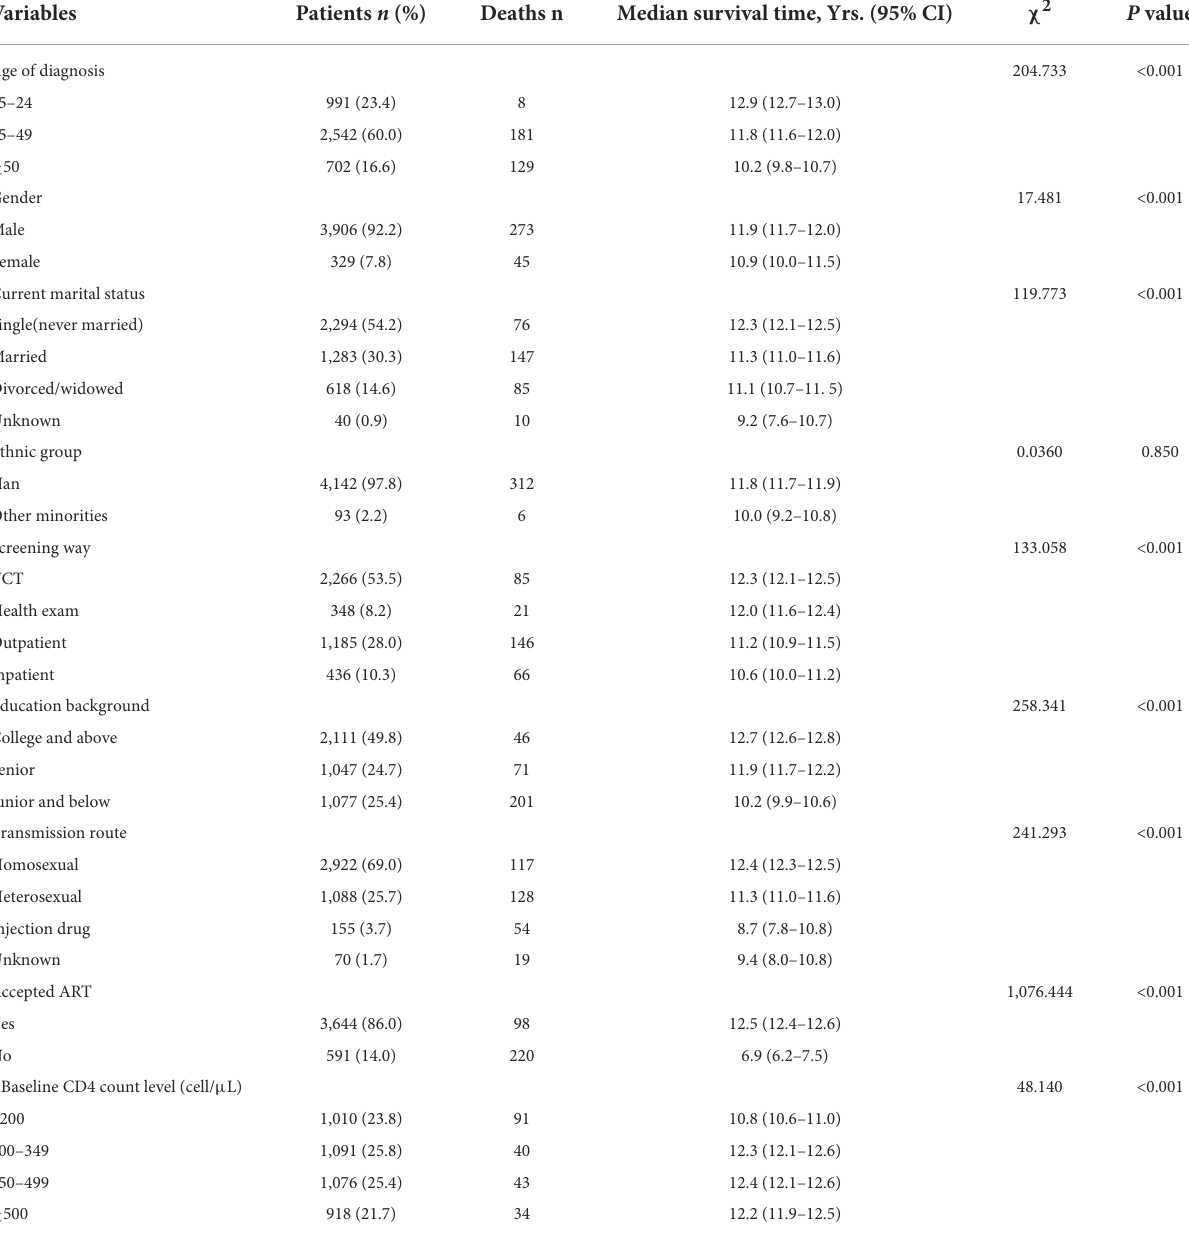
TABLE 2 Survival time and log-rank test of Kaplan-Meier among PLHIV in